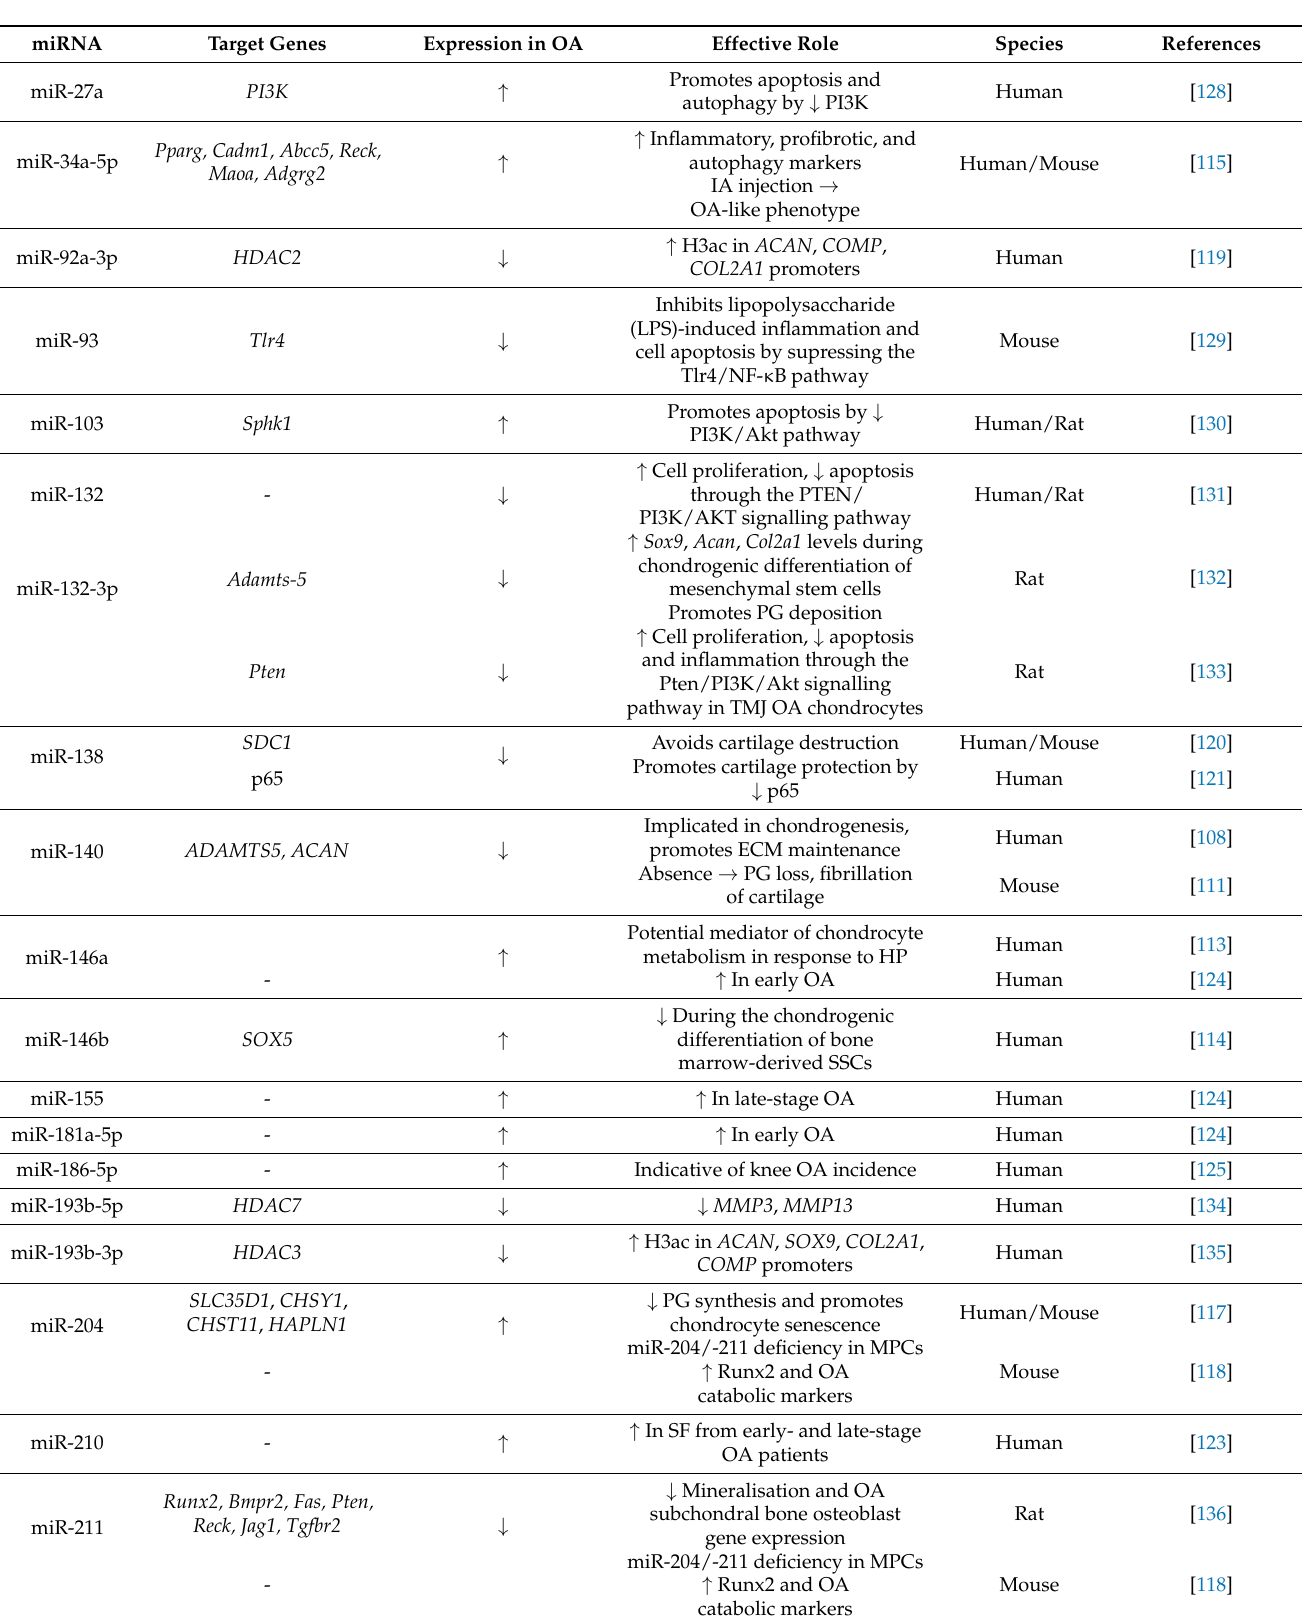
Table 1. Overview of the most relevant miRNAs in